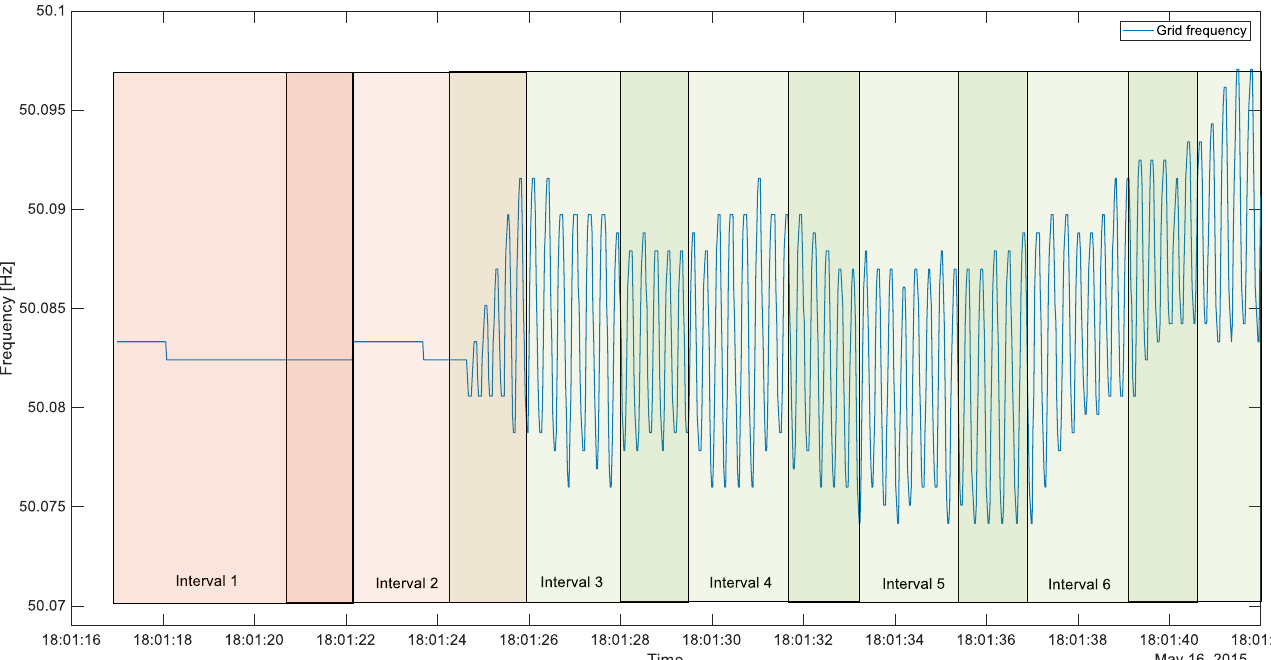
Figure 3. Example of a beginning grid frequnecy oscillation and the detection intervals. Red-shaded boxes mark intervals in which no oscillation is detected, while green-shaded boxes mark intervals with oscillations.